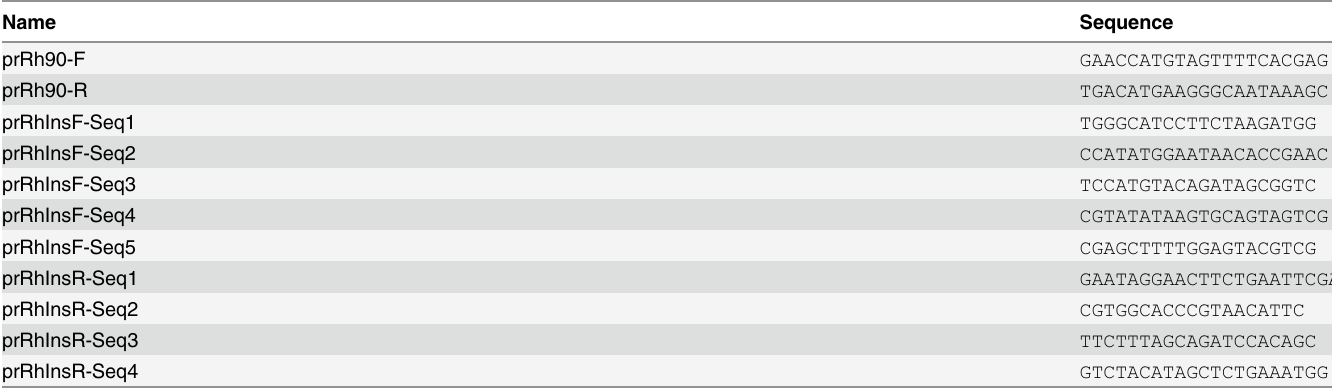
Table 2. Sequencing